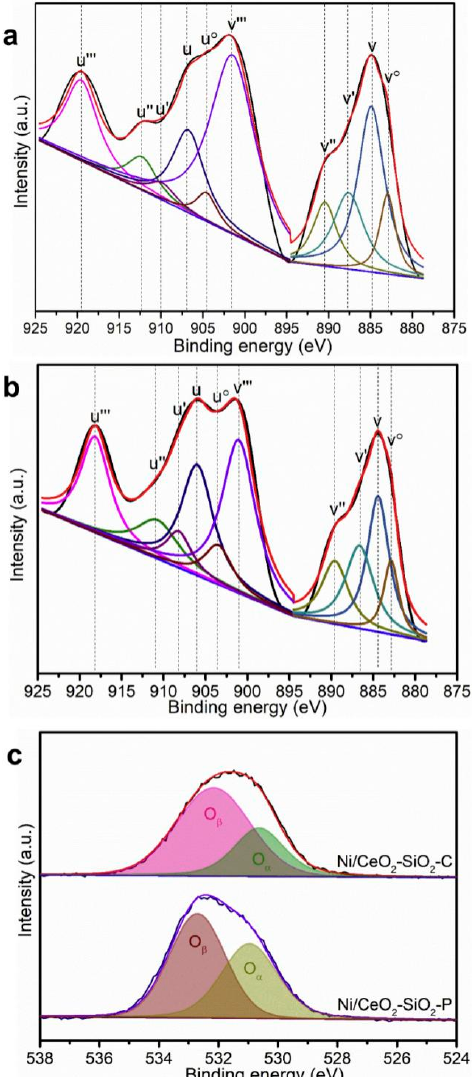
Figure 4. Ce 3d XPS spectra of ( a ) NiO/CeO 2 -SiO 2 -C and ( b ) Ni/CeO 2 -SiO 2 -P, and ( c ) O 1s XPS spectra of the two catalysts. Reproduced with permission from [71], Copyright 2019, Elsevier.